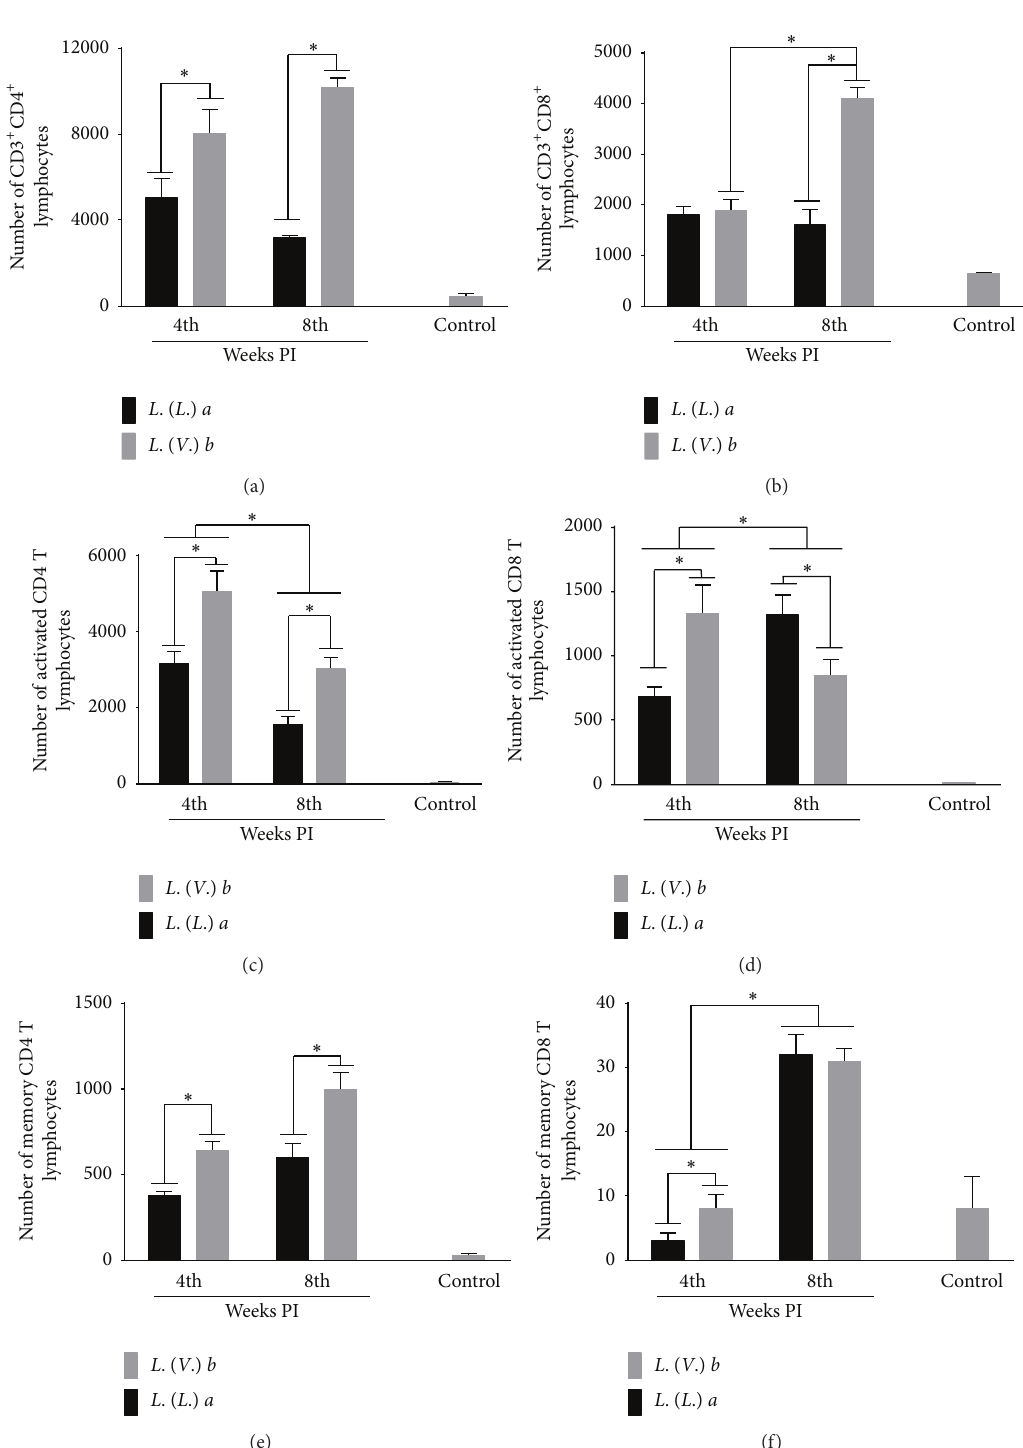
Figure 4: CD4 + and CD8 + T-cell immunophenotyping from the popliteal lymph nodes of BALB/c mice infected with L. (L.) amazonensis or L. (V.) braziliensis . (a) Number of CD3 + CD4 + T-cells. (b) Number of CD3 + CD8 + T-cells. (c) Number of activated CD4 + T-cells (CD 3 + CD 4 + CD 62 L low CD 45 RB high ). (d) Number of activated CD8 + T-cells (CD 3 + CD 8 + CD 62 L low CD 45 RB high ). (e) Number of memory CD4 + T-cells (CD 3 + CD 4 + CD 62 L low CD 45 RB low ). (f) Number of memory CD8 + T-cells (CD 3 + CD 8 + CD 62 L low CD 45 RB low ). Data represent the mean ± SD of three independent experiments. ∗ 𝑝 < 0.05